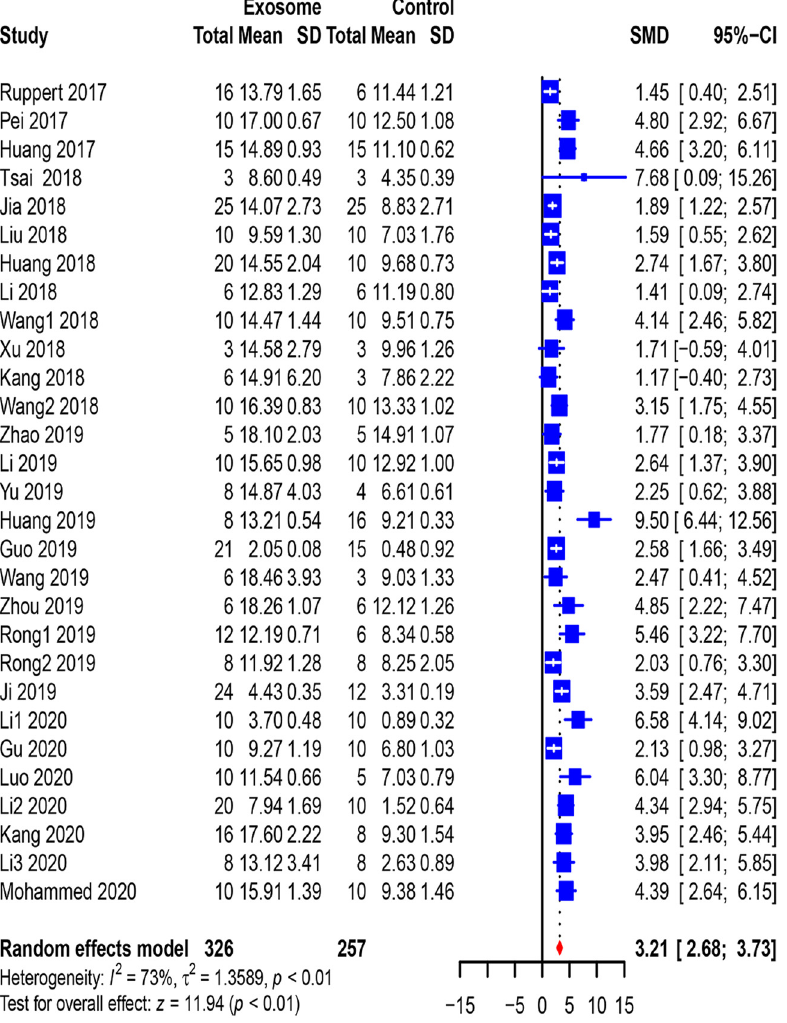
Figure 3: Pooled - analysis of Basso, Beattie, and Bresnahan scale at the last measurement after SCI. SMD, standard mean di ff erence; SD, standard di ff erence; CI, con fi dential